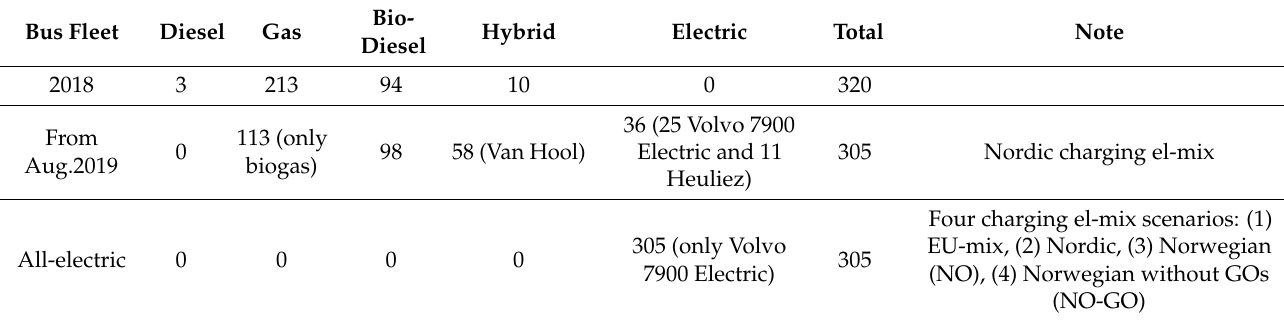
Table 4. Bus fleet scenarios.